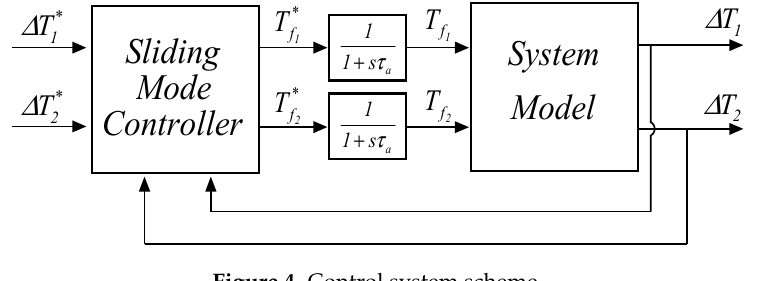
Figure 4. Control system scheme.